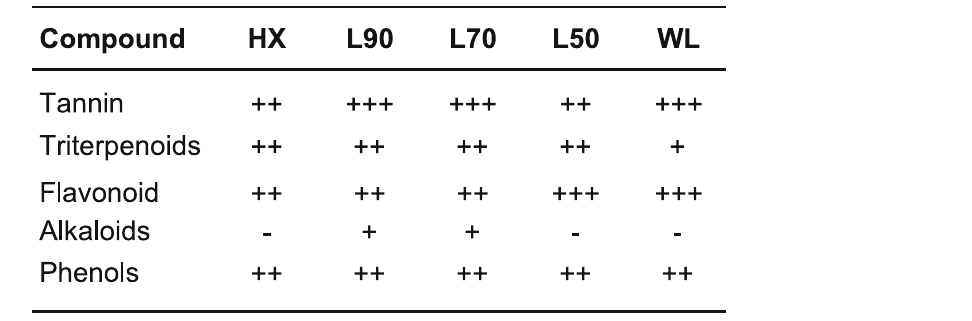
Table 1 Qualitative analysis of B. frutescens leaves phytochemical